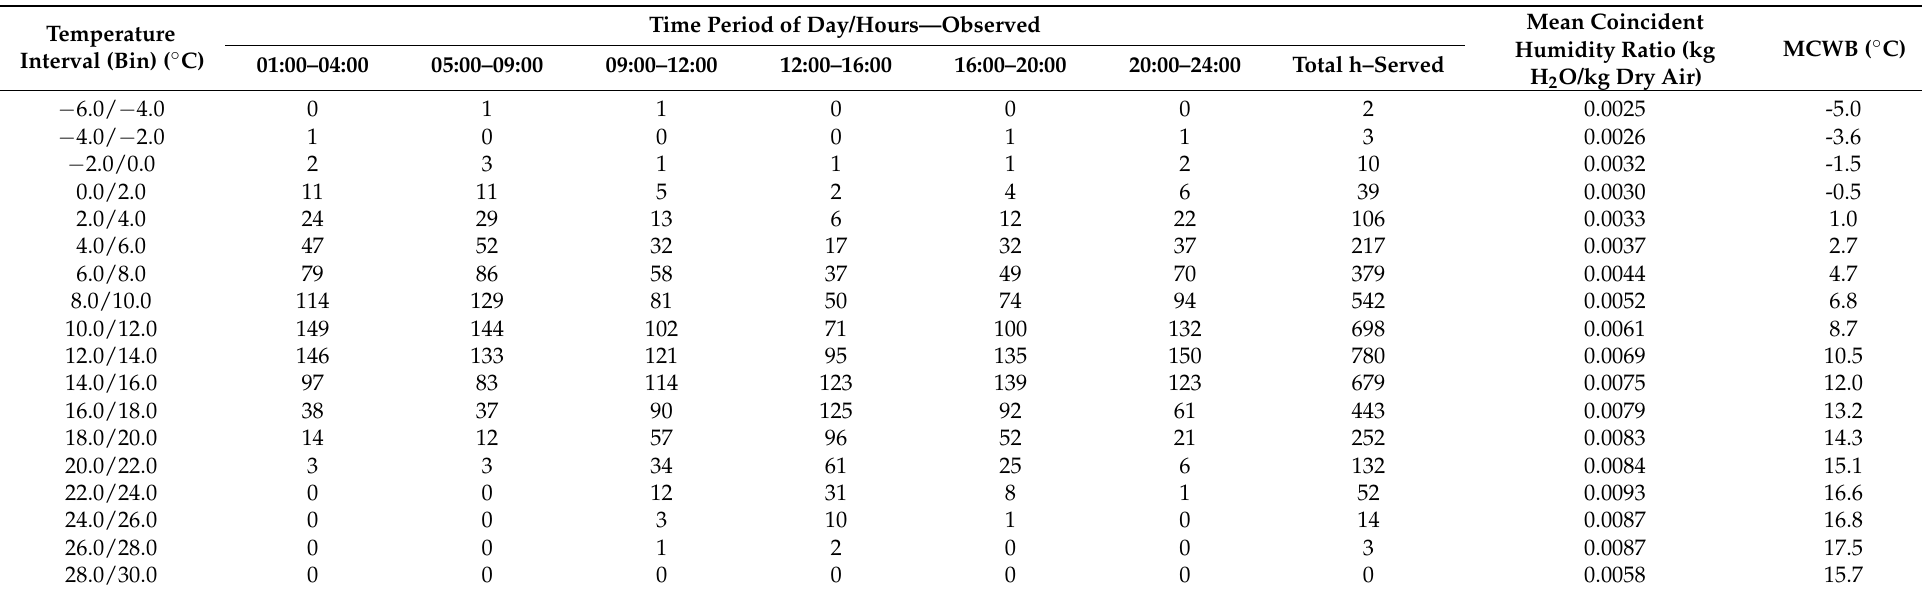
Table 3. Bin data for Athens (NOA). Heating season (November to April)—Period